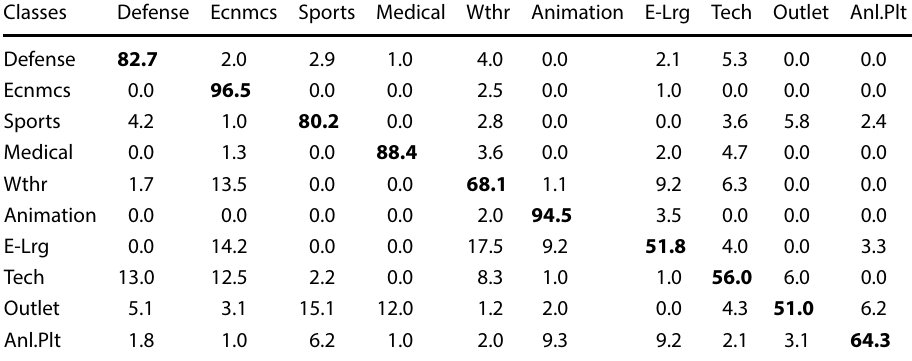
Table 7 Confusion matrix of Vision Transformer (ViT) [39] on STD dataset (ACR: